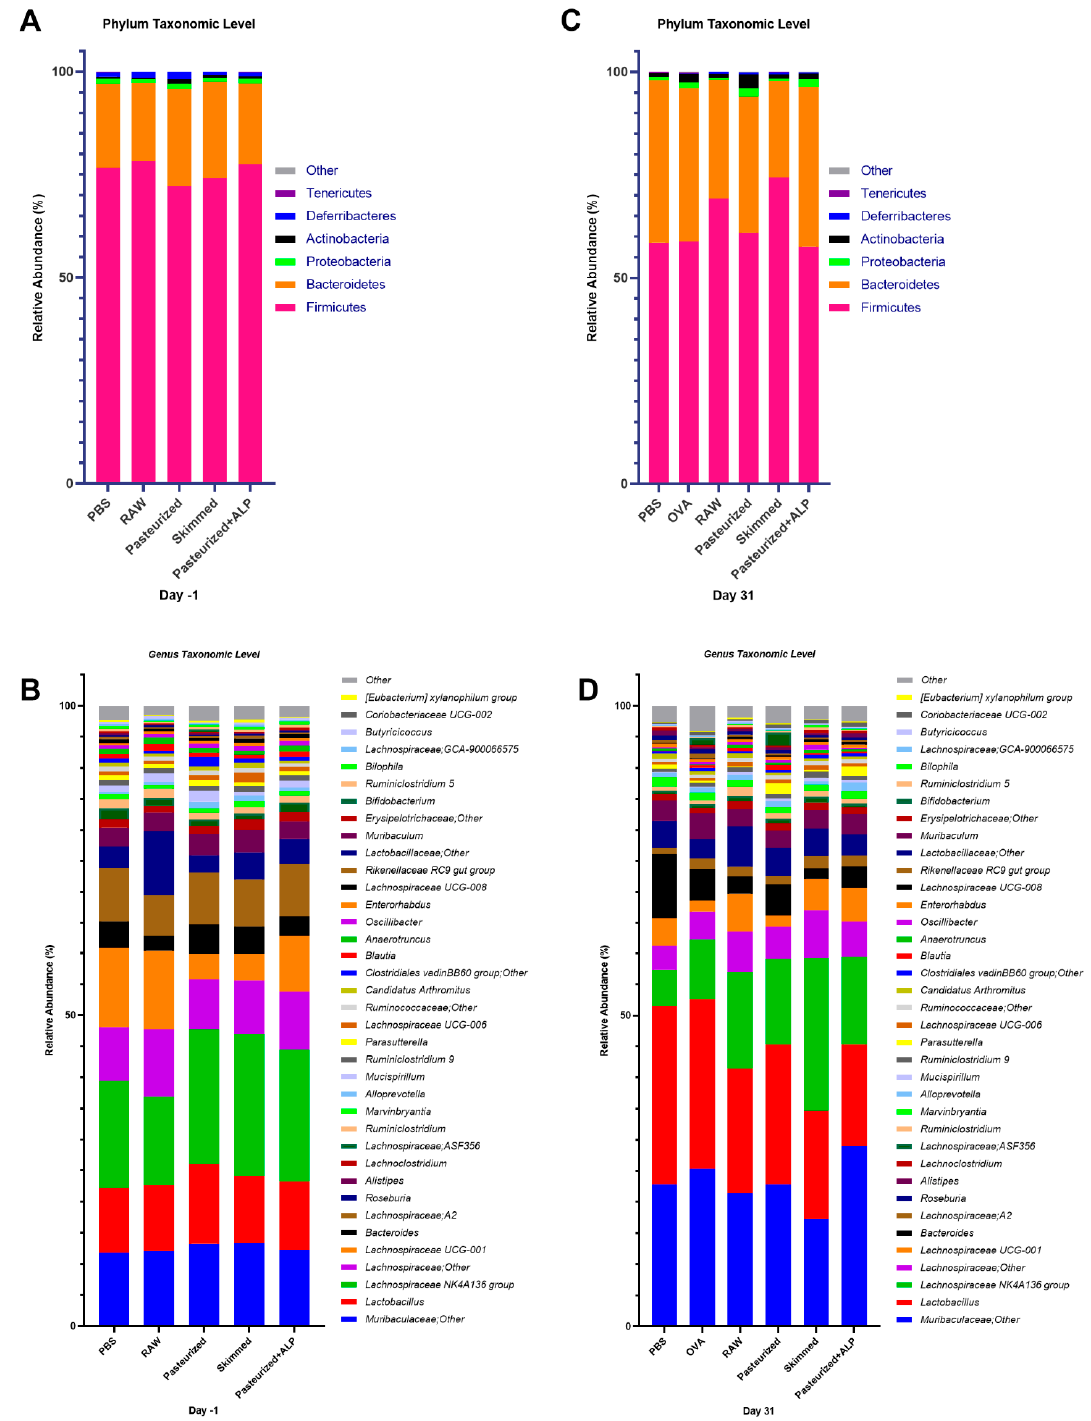
Figure 2. Microbial profiles of the control and experimental groups at day − 1 and day 31. ( A ) Day − 1 stacked column plots depicting the percent mean relative abundance (>1%) of bacterial phyla. ( B ) Day − 1 stacked column plots depicting the percent mean relative abundance (>0.1%) of bacterial genera. ( C ) Day 31 stacked column plots depicting the percent mean relative abundance (>1%) of bacterial phyla. ( D ) Day 31 stacked column plots depicting the percent mean relative abundance (>0.1%) of bacterial genera. PBS, phosphate-buffered saline; OVA, ovalbumin; raw, raw cow’s milk; pasteurized, pasteurized cow’s milk; skimmed, skimmed raw cow’s milk; pasteurized + ALP, pasteurized milk spiked with alkaline